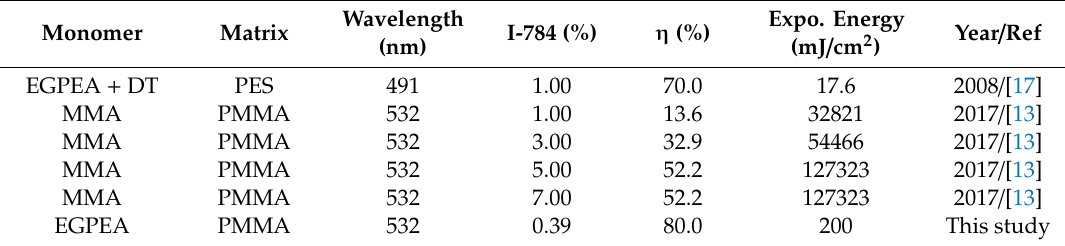
Table 2. Optical performance compared.